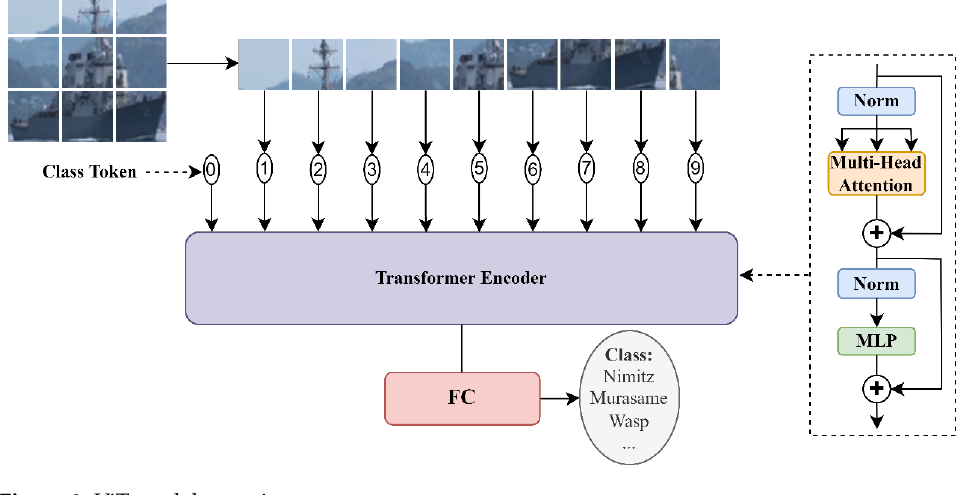
Figure 8. ViT model overview.